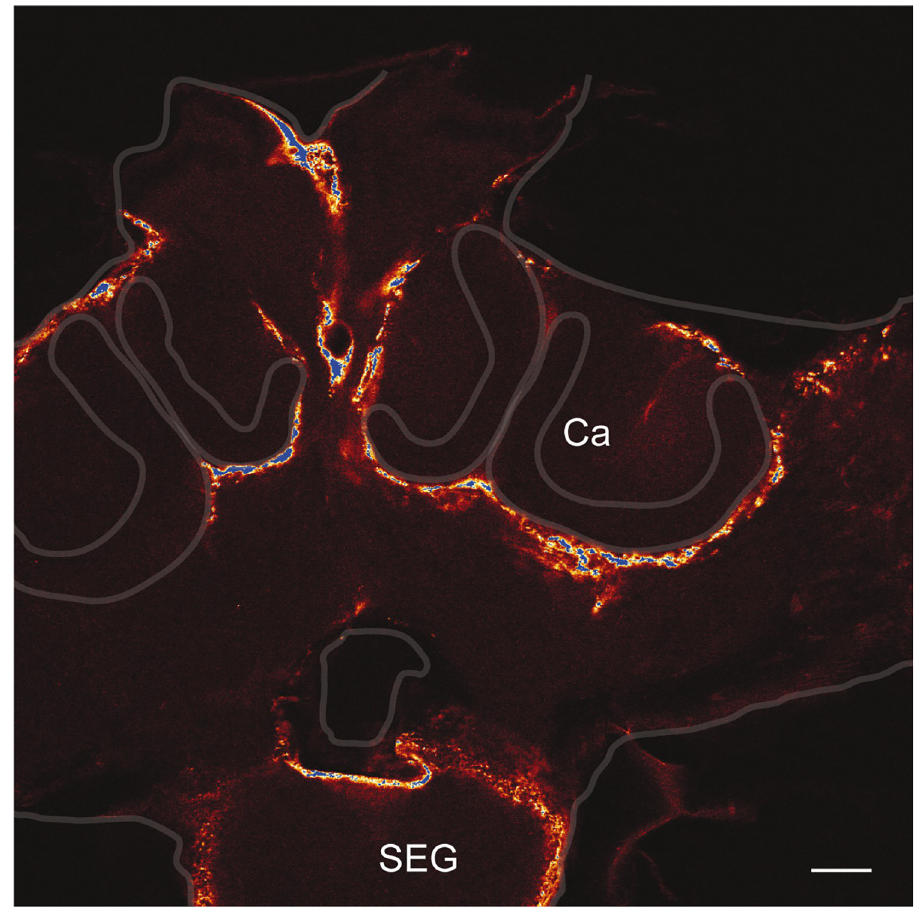
Fig 6. Anti-eGFP signals in bees injected with Lentiviruses. The bees were injected with viral particles through the median ocellus and the brain was dissected 3 days post-injection. Calyx ( Ca ), Suboesophageal ganglion ( SEG ). Scale bar 100 μ